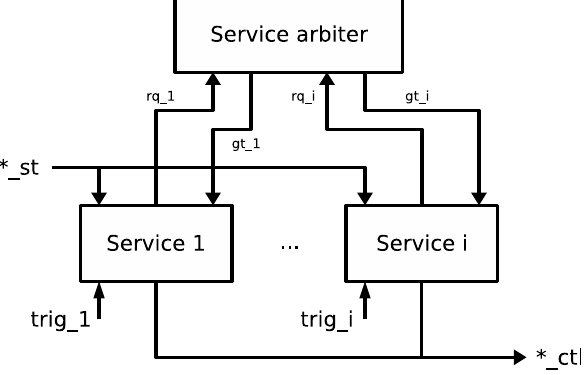
Figure 16. Protocol and configuration interface control unit service